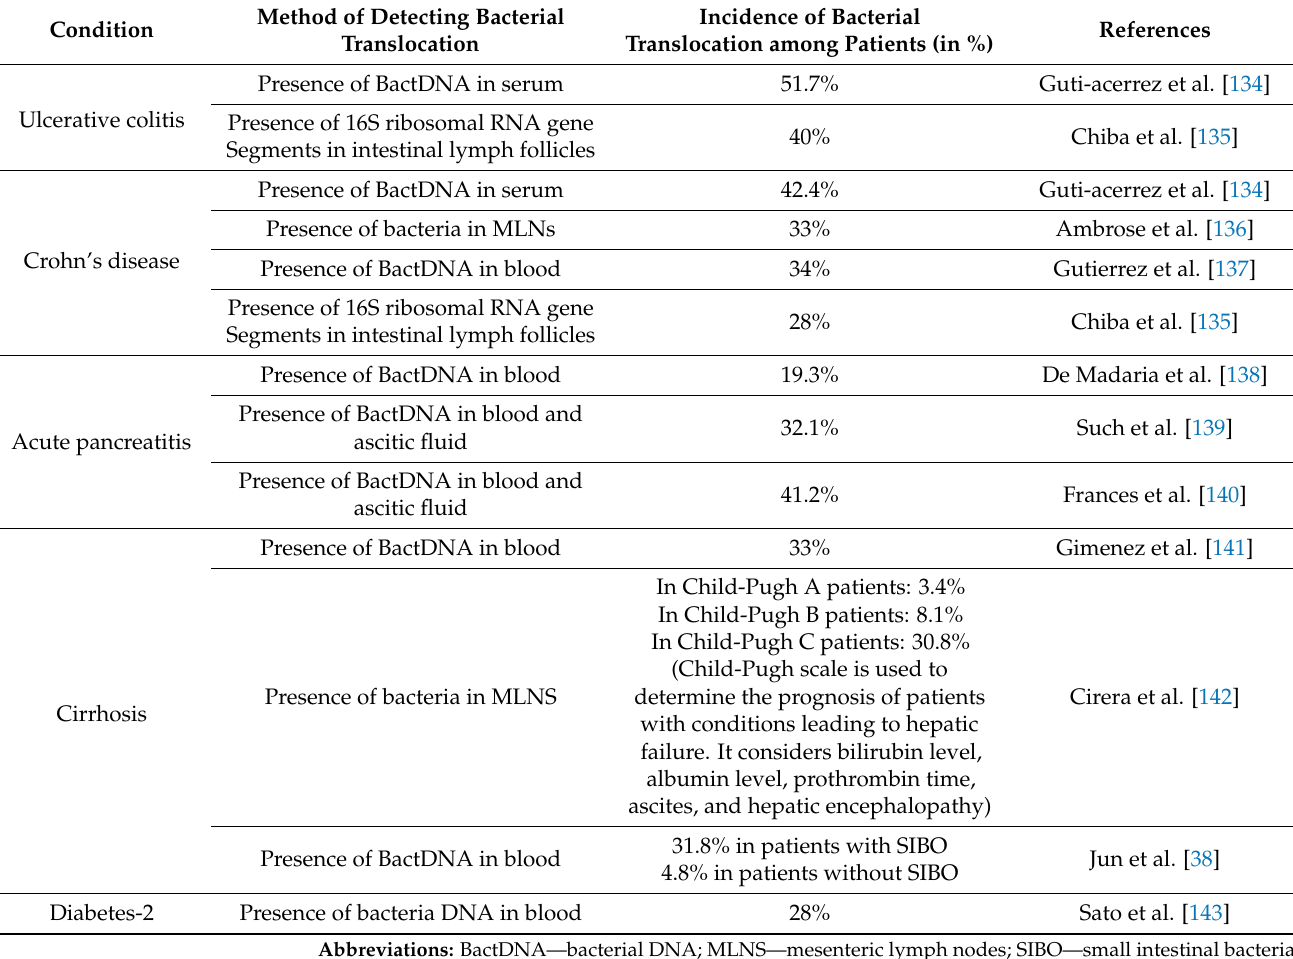
Table 2. Evidence of bacterial translocation in various alimentary tract